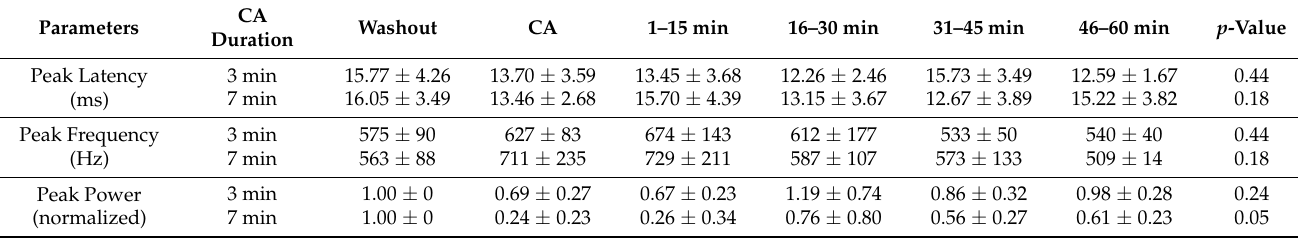
Table A2. HFO TF peak latency, TF peak frequency, and TF peak power evolution (mean ±